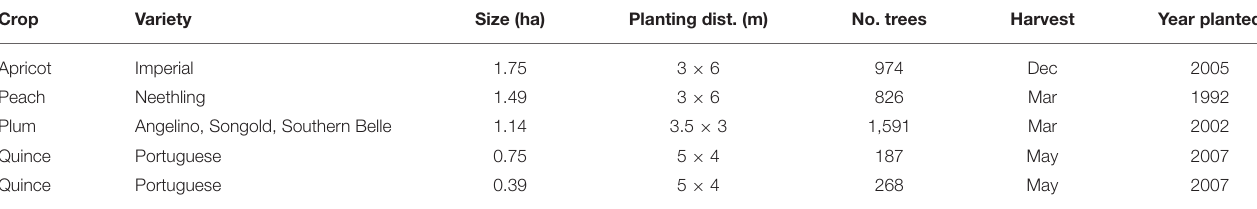
TABLE 1 | The five organically managed temperate fruit orchards sampled at Tierhoek Organic Farm. Crop Variety Size (ha) Planting dist.